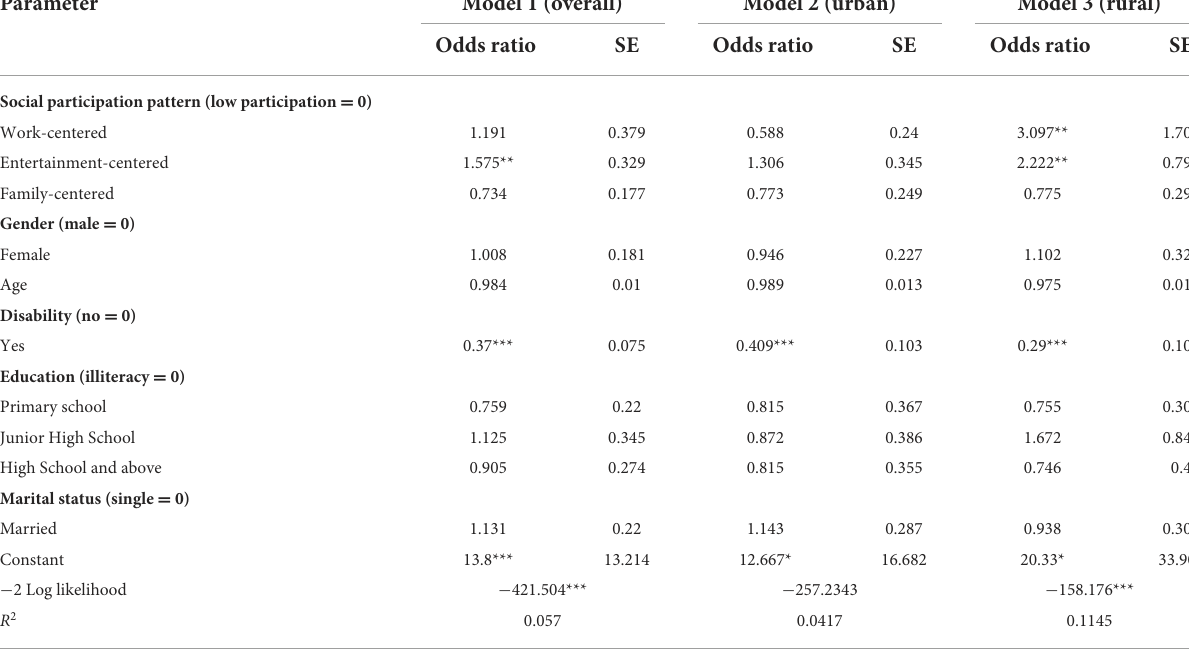
TABLE 8 Logistic regression analysis of associations between social participation pattern and memory ( N = 913). Parameter Model 1